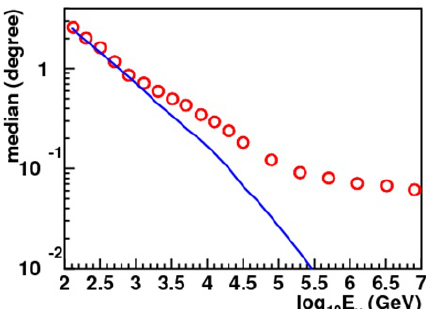
Fig. 4. Median of the distribution of the angle between the neutrino and the reconstructed muon (red points). The blue line is the median of the intrinsic angle between neutrino and muon directions, driven by the dynamics of deep-inelastic neutrino-nucleon scattering and kinematics.